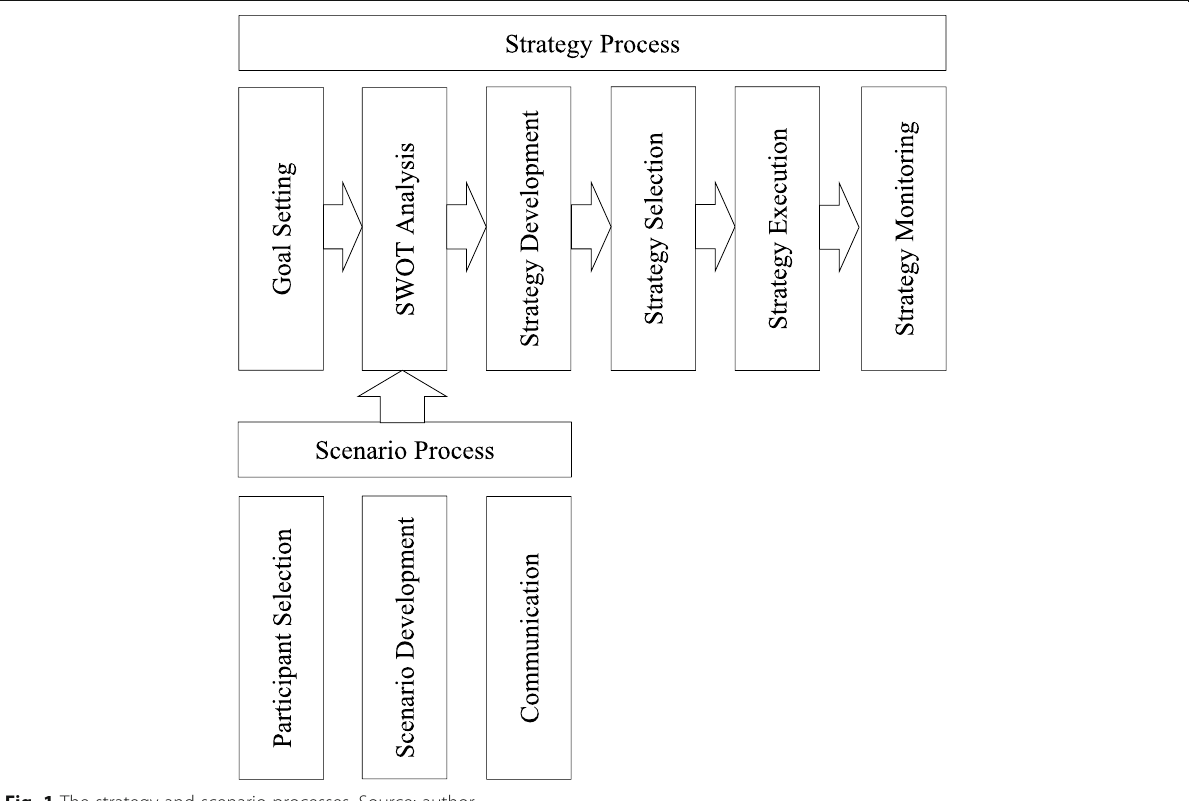
Fig. 1 The strategy and scenario processes. Source: